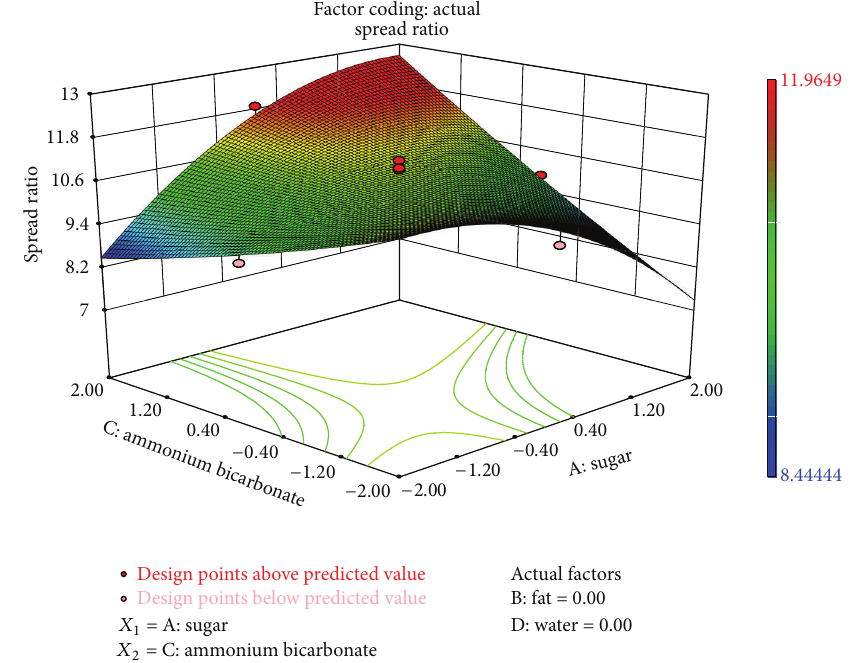
Figure 2: Surface plot representing the effect of sugar ( 𝑋 1 ) and ammonium bicarbonate ( 𝑋 3 ) on spread ratio of the biscuits.